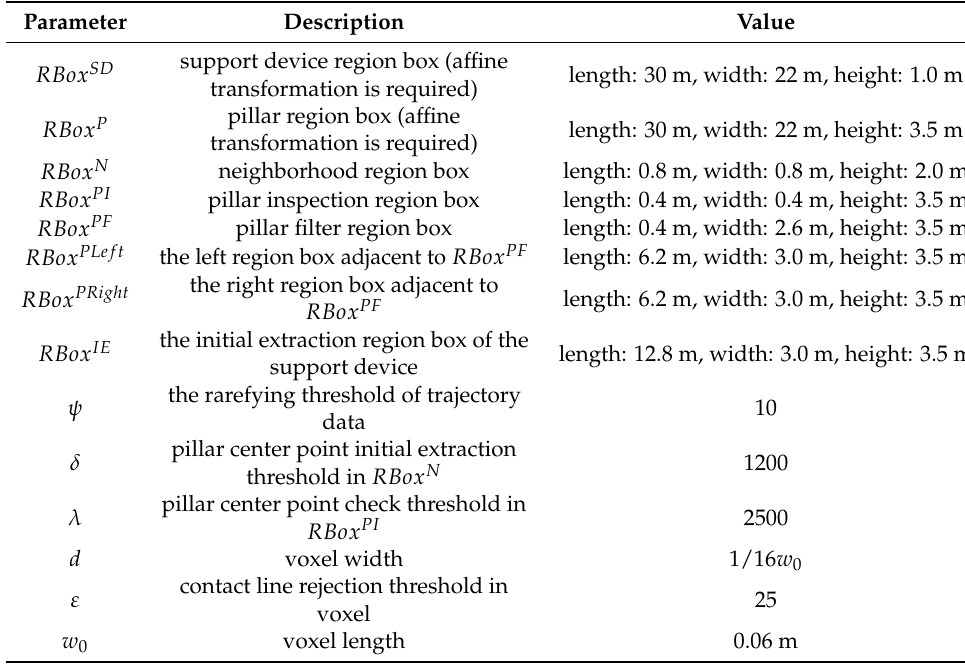
Table 1. Descriptions of the